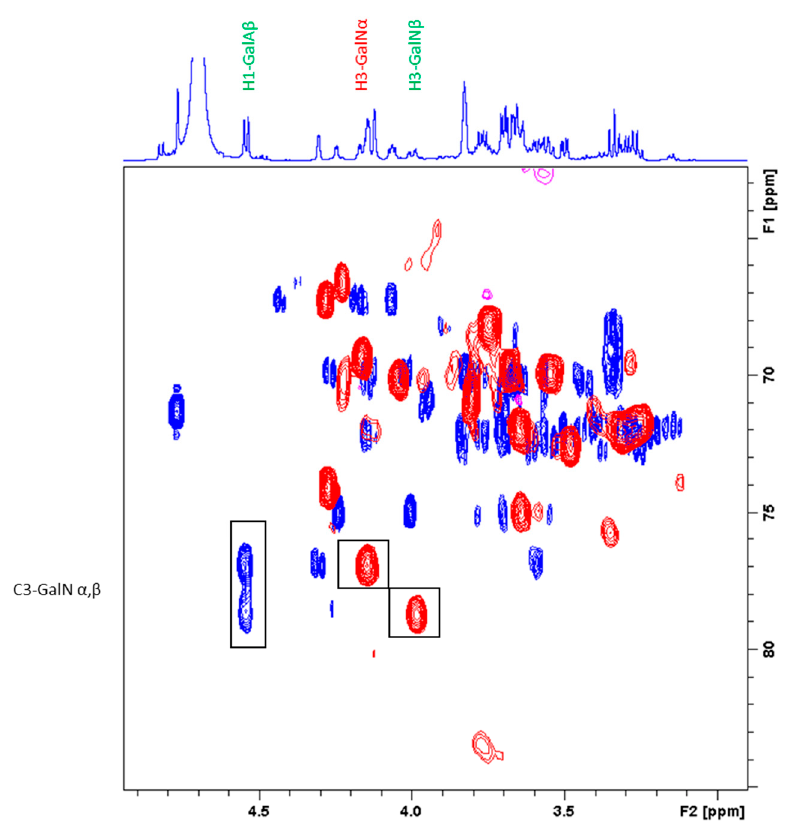
Figure A9. Overlap of 1 H- 13 C HMBC NMR spectrum (Blue) and 1 H- 13 C HSQC NMR spectrum (Red-Pink) of S. flexneri 6 OAg after TFA hydrolysis.